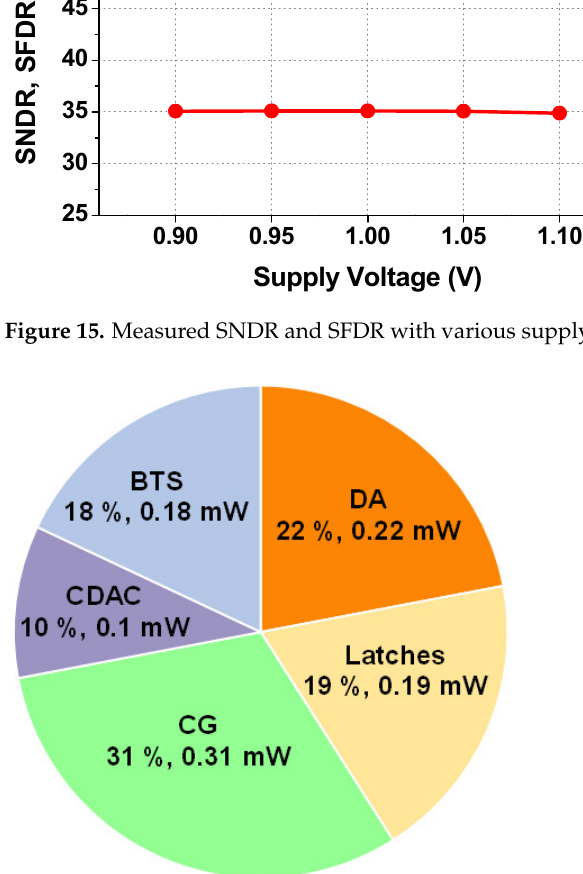
Figure 16. Power breakdown. Figure 16. Power